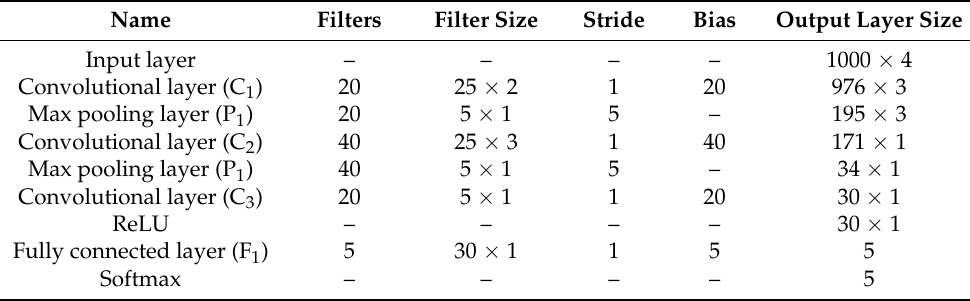
Table 2. Details of the proposed